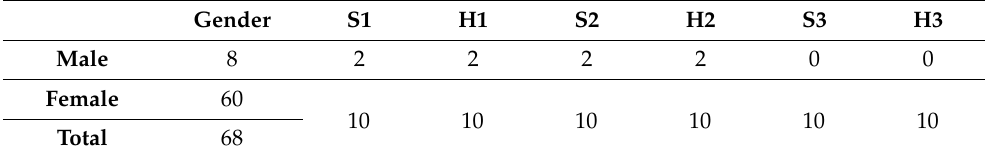
Table 1. Sample size. S1 (the experimental group of the 1st generation that was fed with the soft diet), H1(the experimental group of the 1st generation that was fed with the hard diet), S2 (the experimental group of the 2nd generation that was fed with the soft diet), H2 (the experimental group of the 2nd generation that was fed with the hard diet), S3 (the experimental group of the 3rd generation that was fed with the soft diet), H3 (the experimental group of the 3rd generation that was fed with the hard diet). Gender S1 H1 S2 H2 S3 H3 Male 8 2 2 2 2 0 0 Female 60 10 10 10 10 10 10 Total